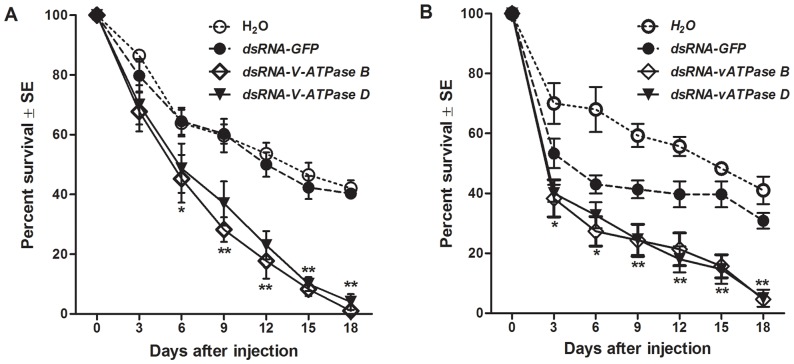

Peregrinus maidis mortality after injection with dsRNA.Fifth-stage nymphs were injected with 40 nL H2O or 40 nL (200 ng) of dsRNA (V-ATPase B, V-ATPase D or GFP). The experiment was performed twice, i.e., two independent biological replicates (A and B). Each point represents the mean ± standard error of the mean of n  =  three experimental replicates with 20 insects per replicate-cage monitored repeatedly over time. The single asterisk (*) indicates that only dsRNA-V-ATPase B treatment mean differs significantly (P<0.05) from either control group mean; a double asterisk (**) signifies that both the means of dsRNA-V-ATPase B and D differ significantly (P<0.05) from that of the controls.